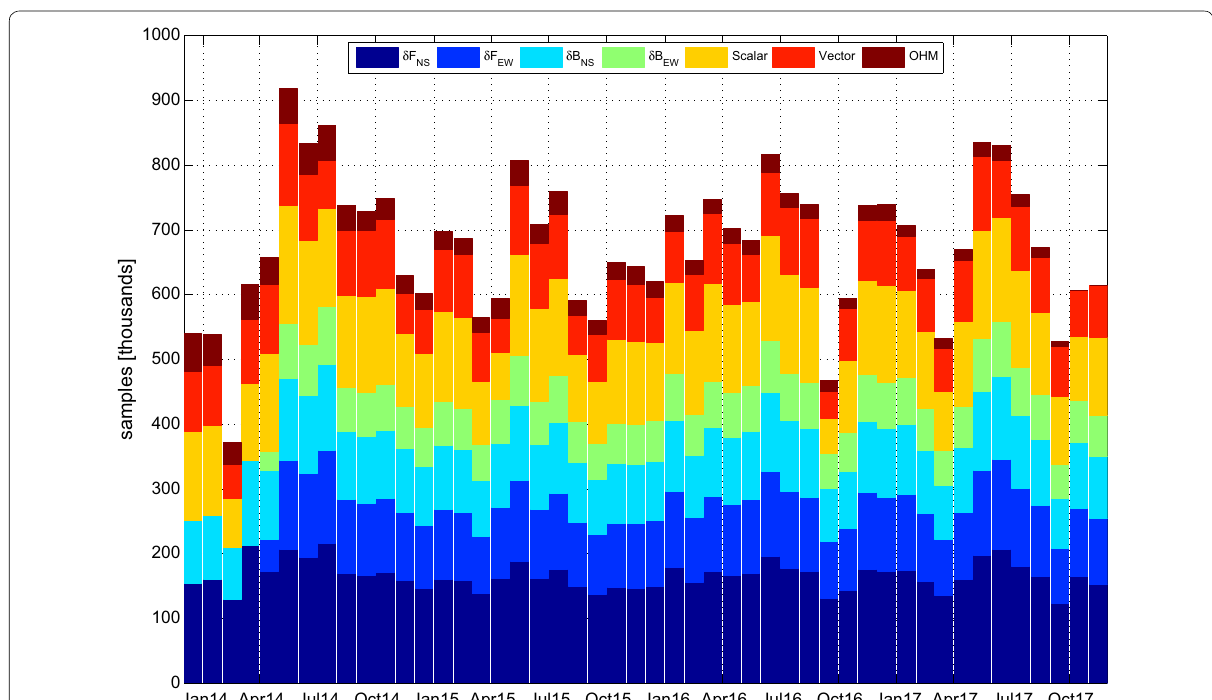
Fig. 1 Data distribution for CIY4 over its time domain showing the Swarm north–south (δ F NS ) and east–west (δ F EW ) scalar difference/sum pairs, the north–south (δ B NS ) and east–west (δ B EW ) vector difference/sum pairs, the single scalar and vector Swarm measurements, and the vector OHM